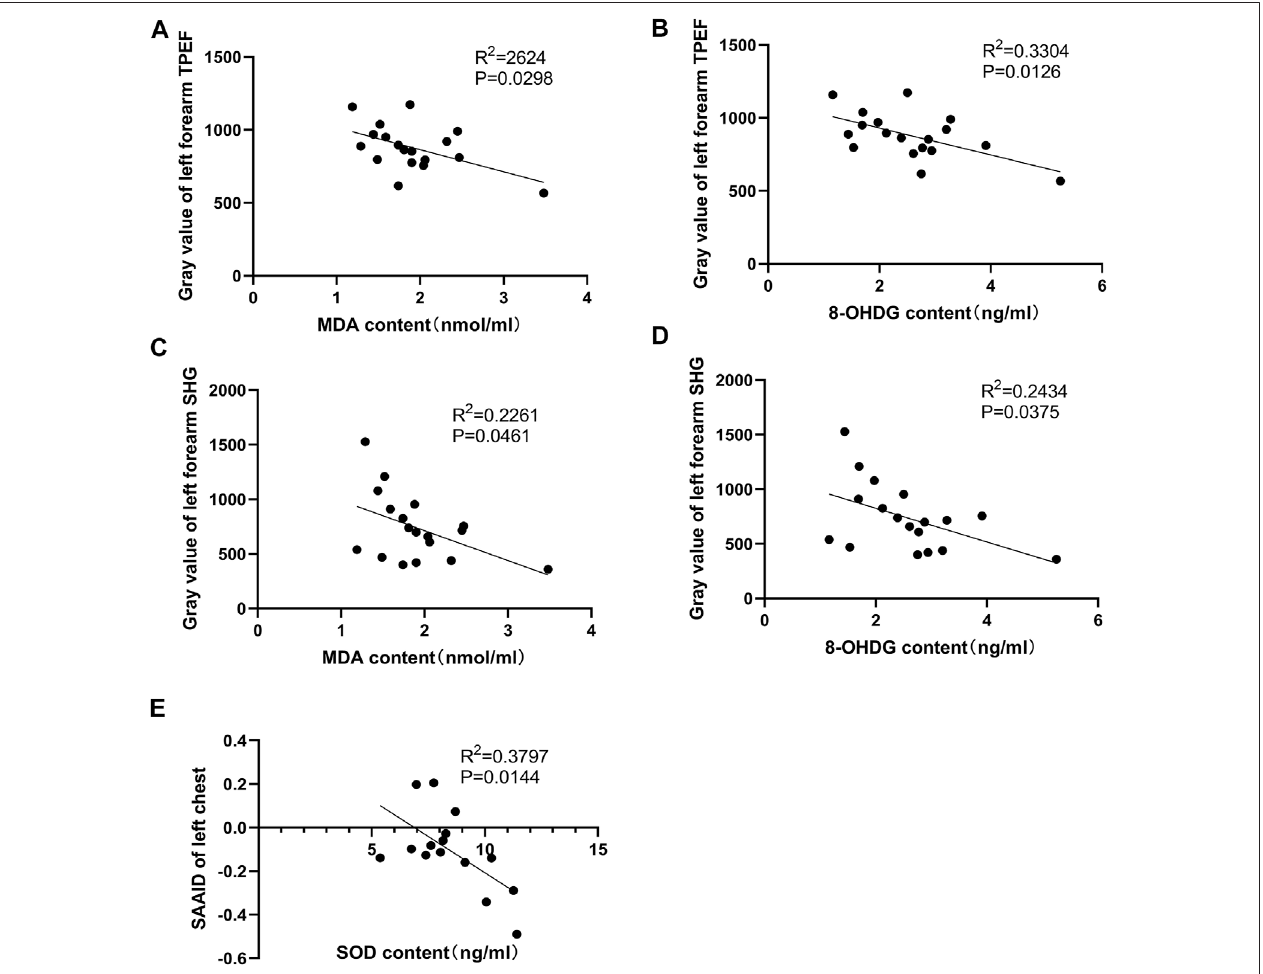
FIGURE 7 | Pearson correlation coef fi cients of two-photon detection indexes and serum biochemical indicators. (A,B) Pearson correlation coef fi cients of serum MDA,8-OHDGandgrayvalueofleftforearmskinTPEF.Therewasasigni fi cantnegativecorrelation. (C,D) Pearsoncorrelationcoef fi cientsofserumMDA,8-OHDG,and gray value of left forearm skin SHG. The left forearm SHG gray value was signi fi cantly negatively correlated with serum MDA and 8-OHDG levels. (E) The SAAID index calculated by TPEF and SHG intensity of left anterior chest were signi fi cantly negatively correlated with serum SOD.